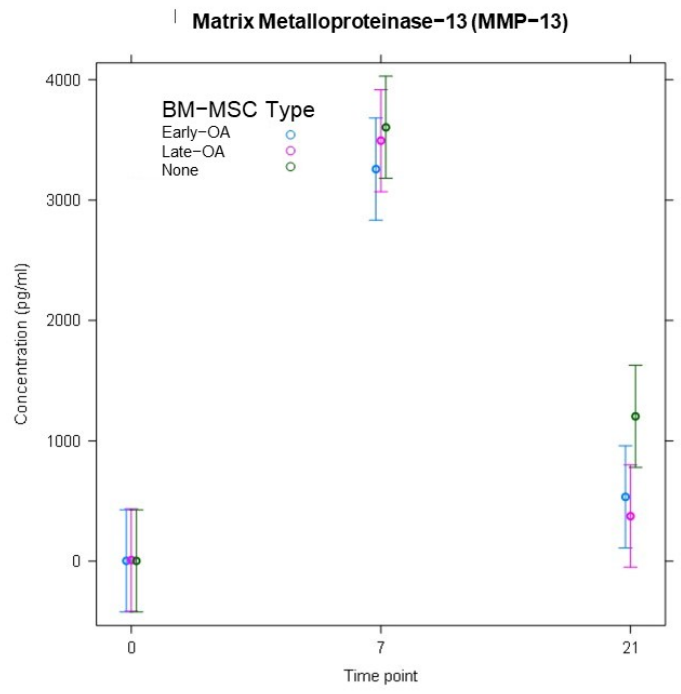
Figure 14. The concentration of VEGF and MMP13 in conditioned media at day 0, day 7 and day 21 of the co-culture model, as determined by ELISA. Error bars represent the standard error of the mean. Significant differences are indicated by vertical black bars.